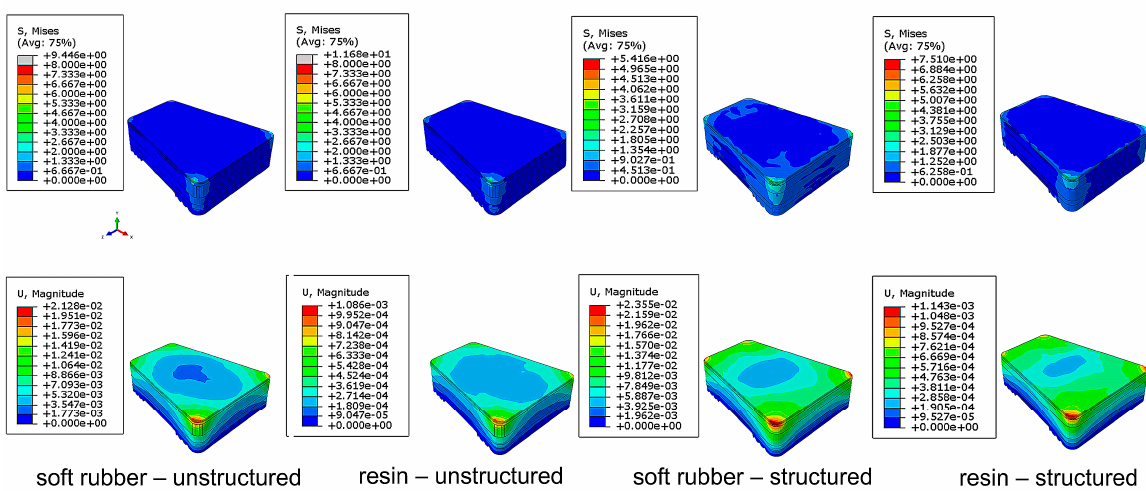
Figure 3. Distributions of the maximum principal stress ( top ) and the spatial displacement ( bottom ) of the four bionic heel pads under a 1500-N concentrated load in FE simulations.